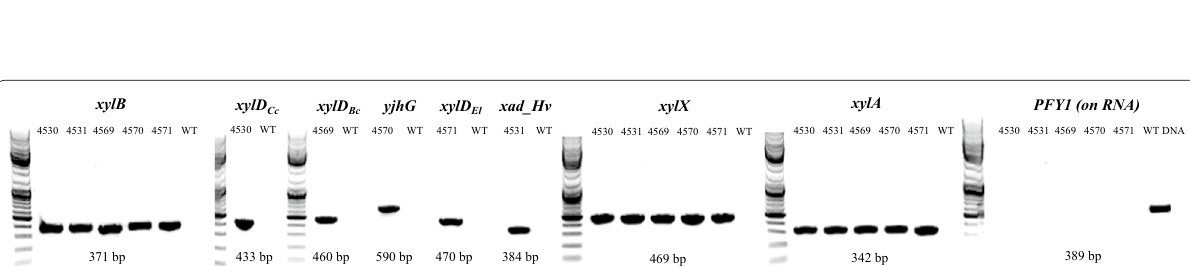
Fig. 6 Reverse‑transcriptase PCR analysis to verify gene expression of Weimberg pathway genes. RNA from five different strains exponentially growing on d ‑glucose was purified and used for cDNA synthesis. Reverse‑transcriptase PCR was performed on the cDNA using primers specific for each Weimberg pathway gene. Amplification of xylB , xylA and xylX was carried out in all strains while different xylD s was amplified in each individual strain as follows: xylD from Caulobacter crescentus in TMB4530, xad from Haloferax volcanii in TMB4531, xylD from Burkholderia cenocepacia in TMB4569, yjhG from Escherichia coli in TMB4570 and xylD from Ellin329 isolate in TMB4571. CEN.PK 113‑7D (WT) was used as negative control. Before cDNA synthesis the RNA purity (i.e. removal of DNA) was examined using a control PCR that amplifies the constitutively expressed gene PFY1 encoding